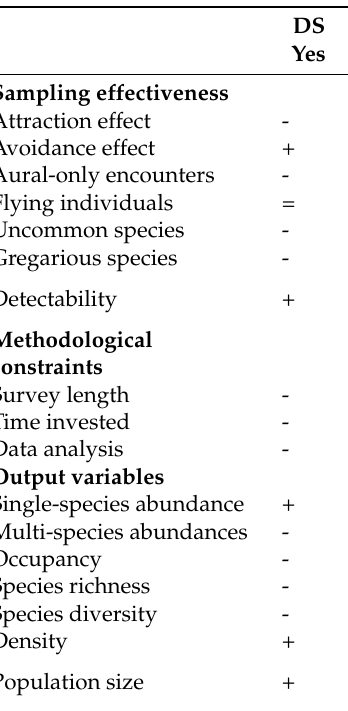
Table 1. Comparison of strengths (+) and weaknesses (-) when using distance sampling modeling (DS Yes) or not (DS No) for estimating parrot abundances through roadside surveys, attending to the shortcomings of both methods and the objectives of studies. Equal signs (=) denote similar